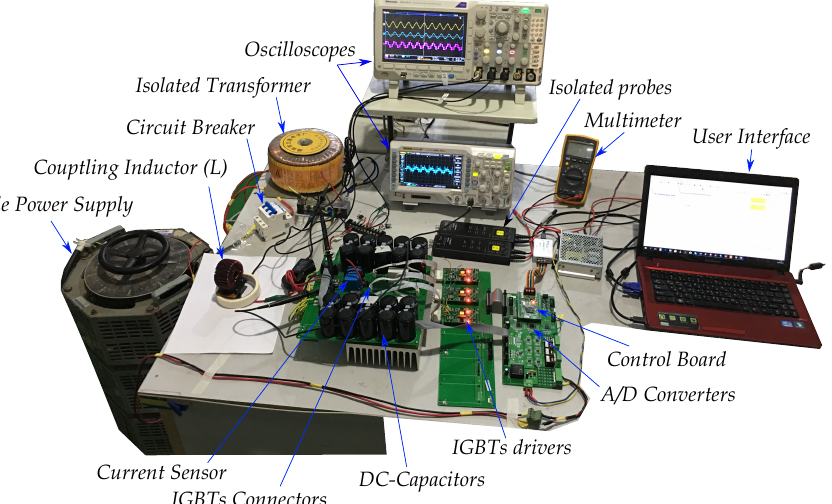
Figure 12. Experimental prototype of CCHB multilevel inverter.